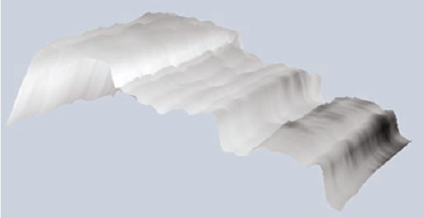
Figure 6: Underwater image of dark-gray-painted, sanded, metallic ladder immersed in relatively turbid water ( k = 0 . 3m − 1 ) at a distance of 3.7 m from receiver obtained by AMULOR working at f m = 50MHz.